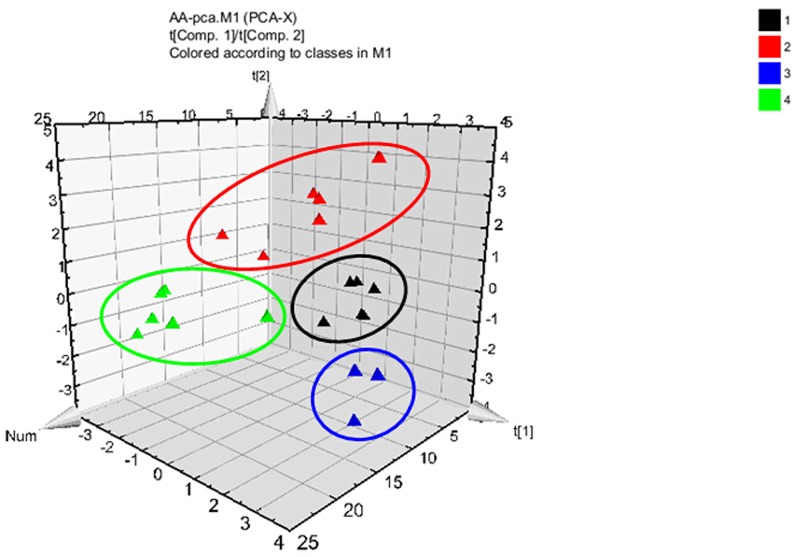
The PCA analysis of amino acids among normal groups (black), DMN model groups (red), ZYC-1 treatment groups (blue) and IFN-α2b treatment groups (green).t[1] and t[2] are the first two eigenvectors of original data.